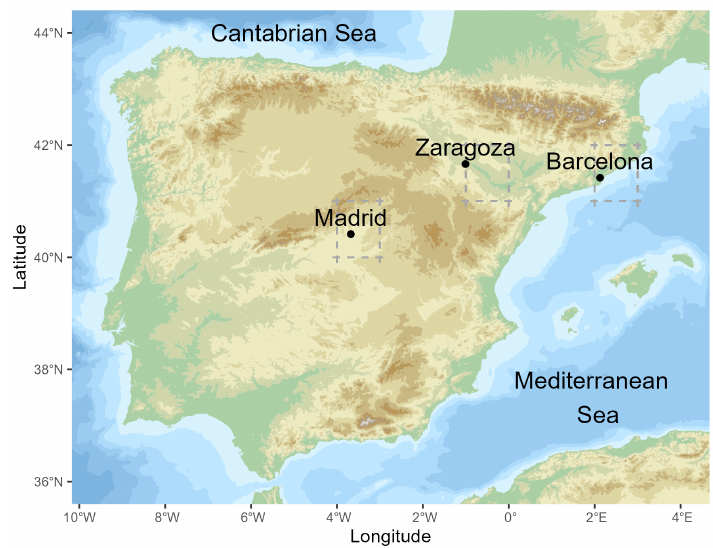
Figure 1. Location of the temperature series in the Iberian